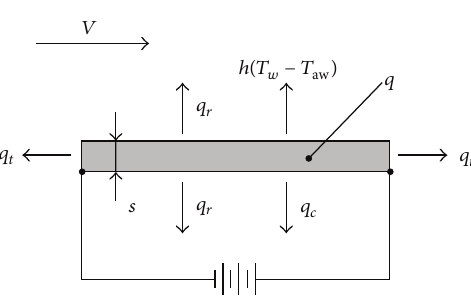
Figure 2: Sketch of the heated thin foil sensor with the considered heat